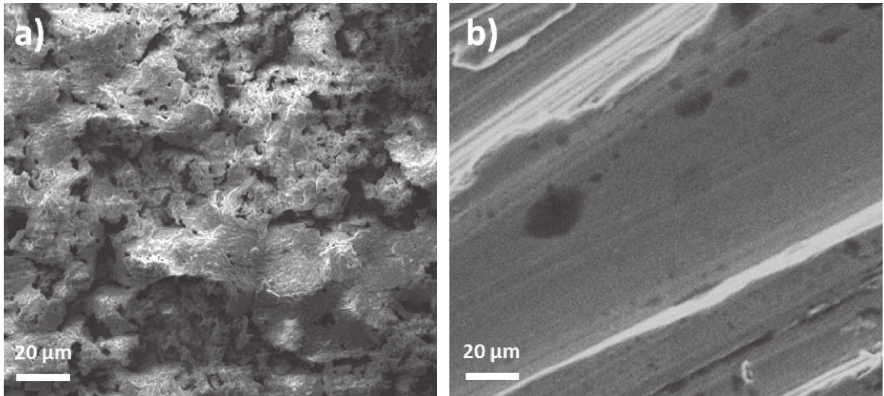
Figure 5: SEM micrographs of copper surfaces (250x magnitude). (a) Copper surface without corrosion inhibitor. (b) Copper surface with corrosion inhibitor at optimum condition (0.2mM stearamidine, 300K).